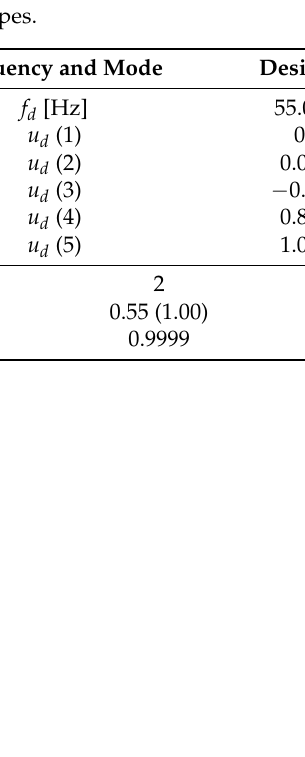
Figure 14. Comparison of desired and attained modes: 55 Hz.